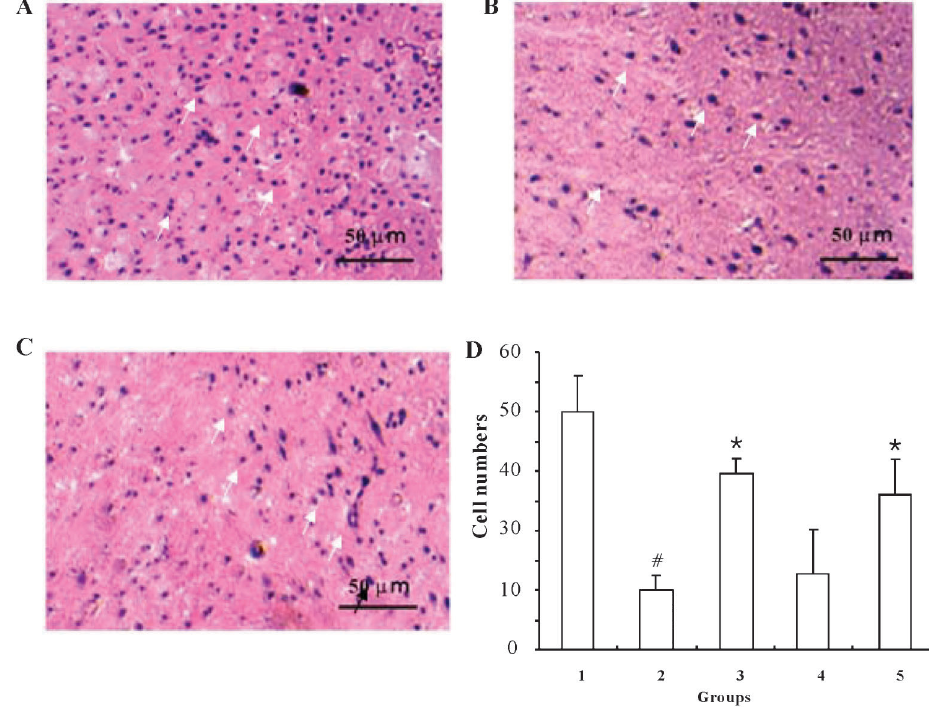
Figure 5. Ischemic preconditioning (IPC) inhibits ischemic reperfusion (I/R)-induced cell death 24 h post-ischemic injury (HE staining). A , Representative image of sham control. B , Representative image of I/R. C , Representative image of 5 6 5 6 5 min IPC ++ I/R group. D , Pooled data are reported as means±SE of 4 rats in each group. Groups: 1) sham control, 2) I/R, 3) 5 6 5 6 5 min IPC++I/R, 4) 3-methyladenine++5 6 5 6 5 min IPC++I/R, and 5) rapamycin++5 6 5 6 5 min IPC++I/R. Arrows indicate the nucleus staining. # P , 0.05, compared to sham control group; *P , 0.05, compared to I/R group (one-way ANOVA followed by the Bonferroni